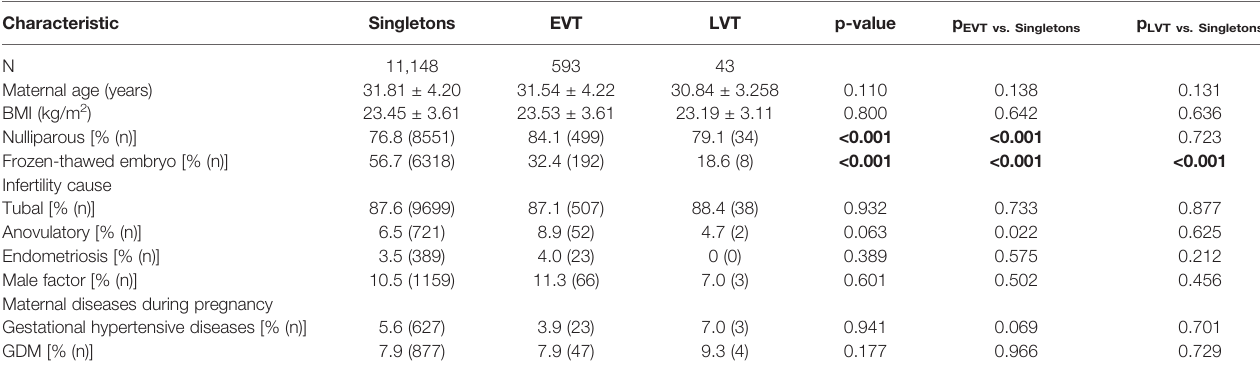
TABLE 1 | Maternal characteristics of vanishing twins and